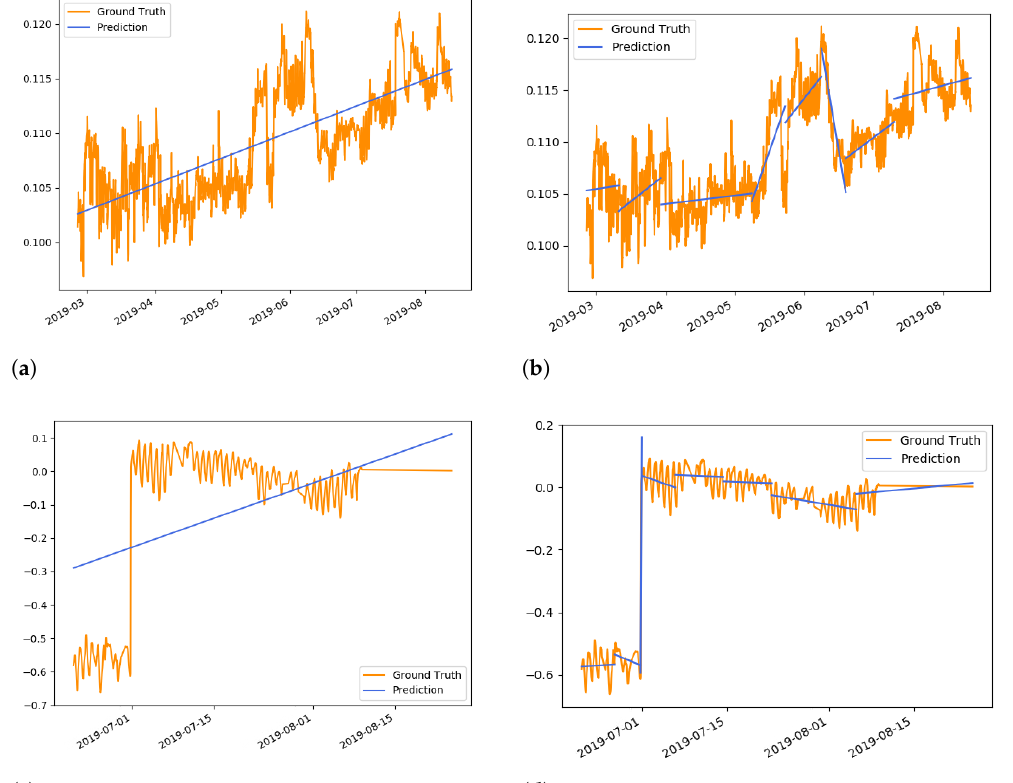
Figure 7. Prediction of linear regression and segmented nonlinear regression on Crack A1 and Crack B1 train set. ( a ) Linear Regression on Crack A1 train set. ( b ) Segmented Nonlinear Regression on Crack A1 train set. ( c ) Linear Regression on Crack B1 train set. ( d ) Segmented Nonlinear Regression on Crack B1 train set.